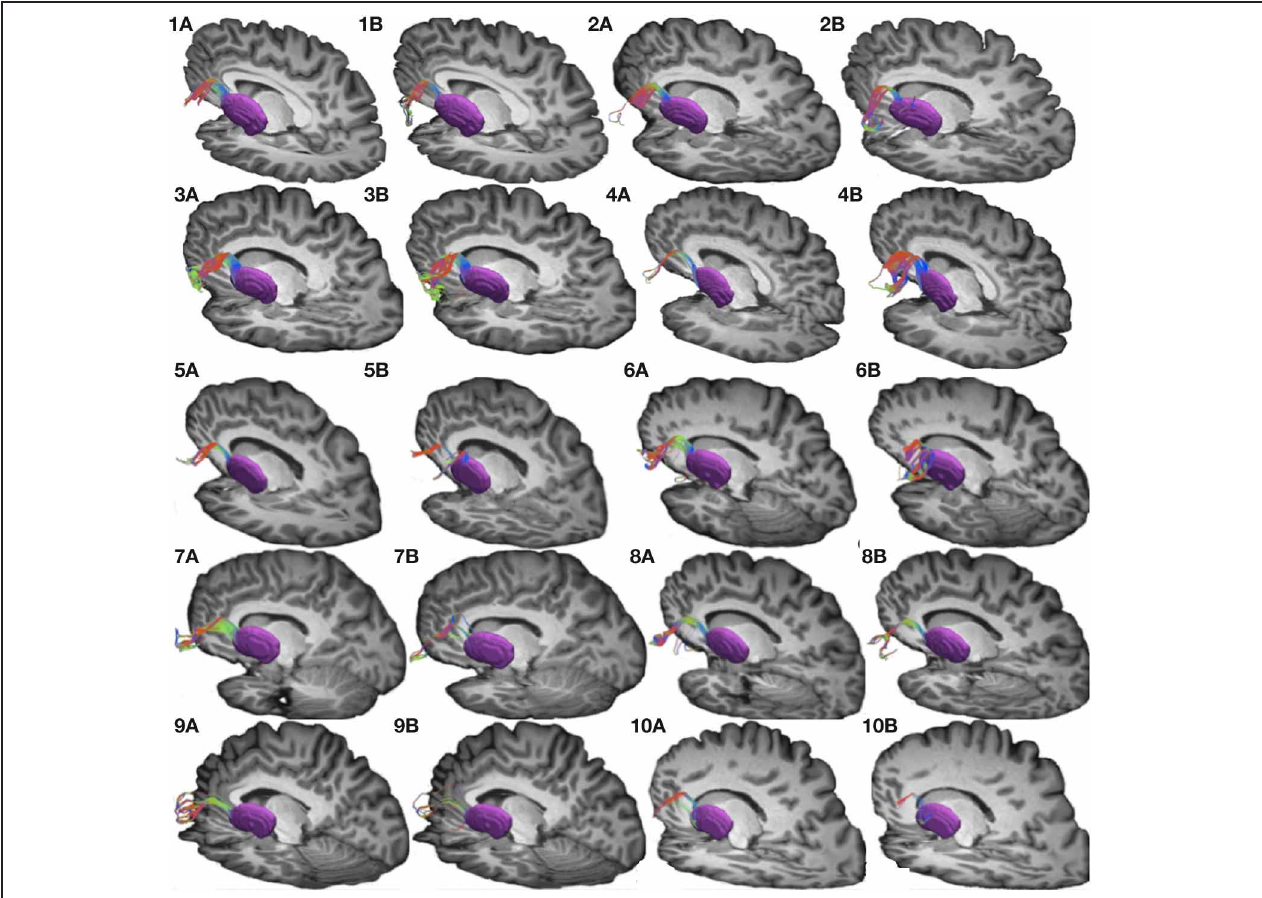
FIGURE 2 | Connections between pars triangularis (A) and pars opercularis (B) and putamen (purple) in each of our ten participants. Color gradient represents the same directionality as in Figure 1